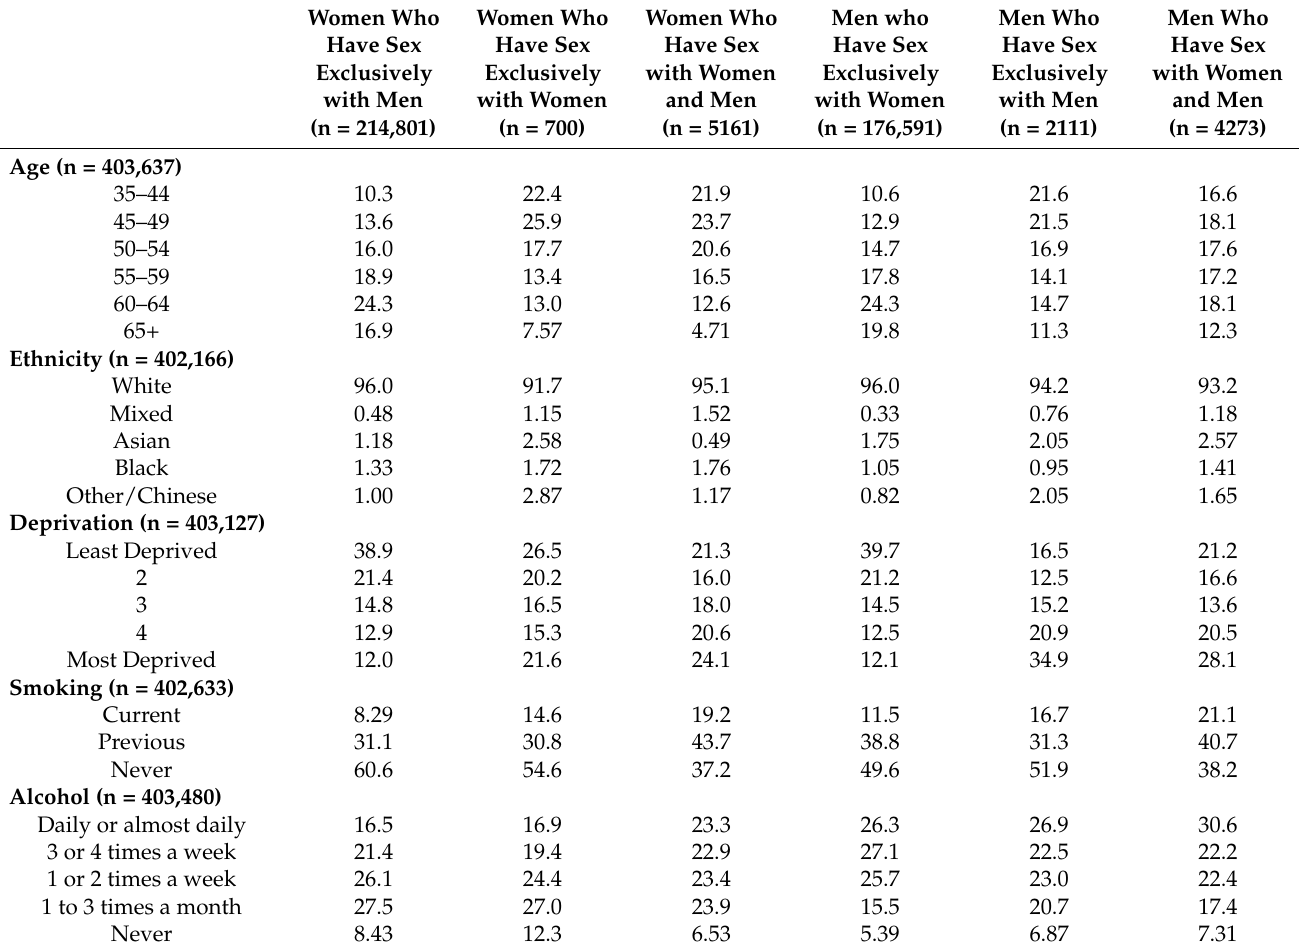
Table 1. Cohort characteristics, stratified by sexual history